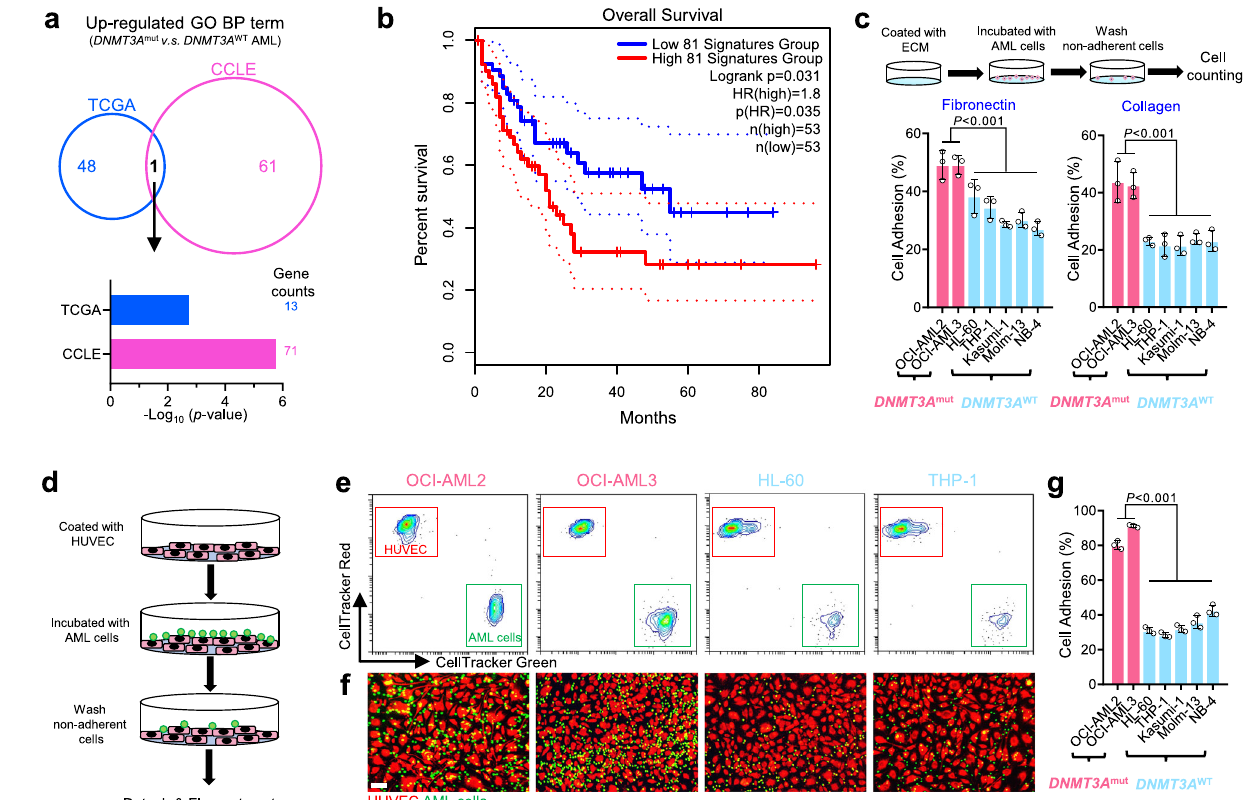
Fig. 1 | Cell adhesion was predominantly enriched in DNMT3A mutant AML cells. a Venn diagram of up-regulated BPterms in DNMT3A -mutantAMLcells from bothAMLpatients(TCGA: DNMT3A mut , n =36; DNMT3A wt , n =115)andAMLcelllines (CCLE: DNMT3A mut , n =4; DNMT3A wt , n =30). b SurvivalcurvesofAMLpatientswith high and low expression designated gene set, and n is the number of biologically independent samples. The survival analysis was performed by the log-rank (Mantel – Cox)test. c CelladhesionassayforhumanAMLcellsseededon fi bronectin or collagen. n =3 biologically independent experiments. d Cell-cell adhesion